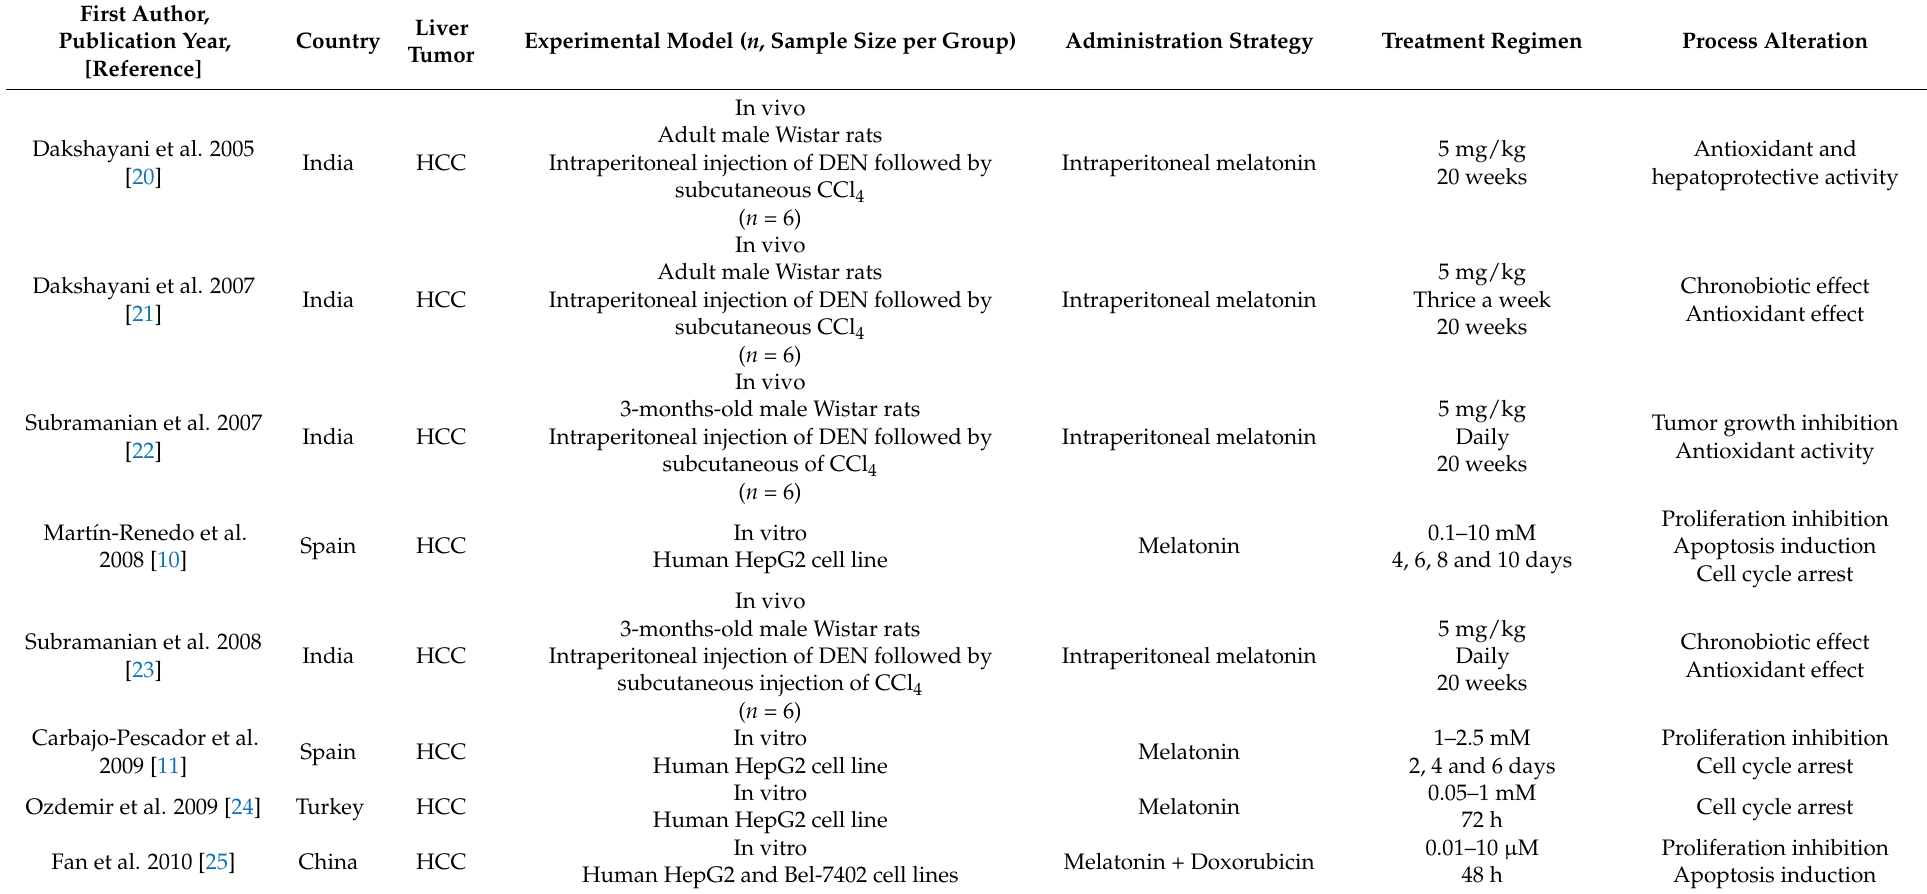
Table 1. Basic characteristics of experimental studies evaluating antitumor effects of melatonin against liver